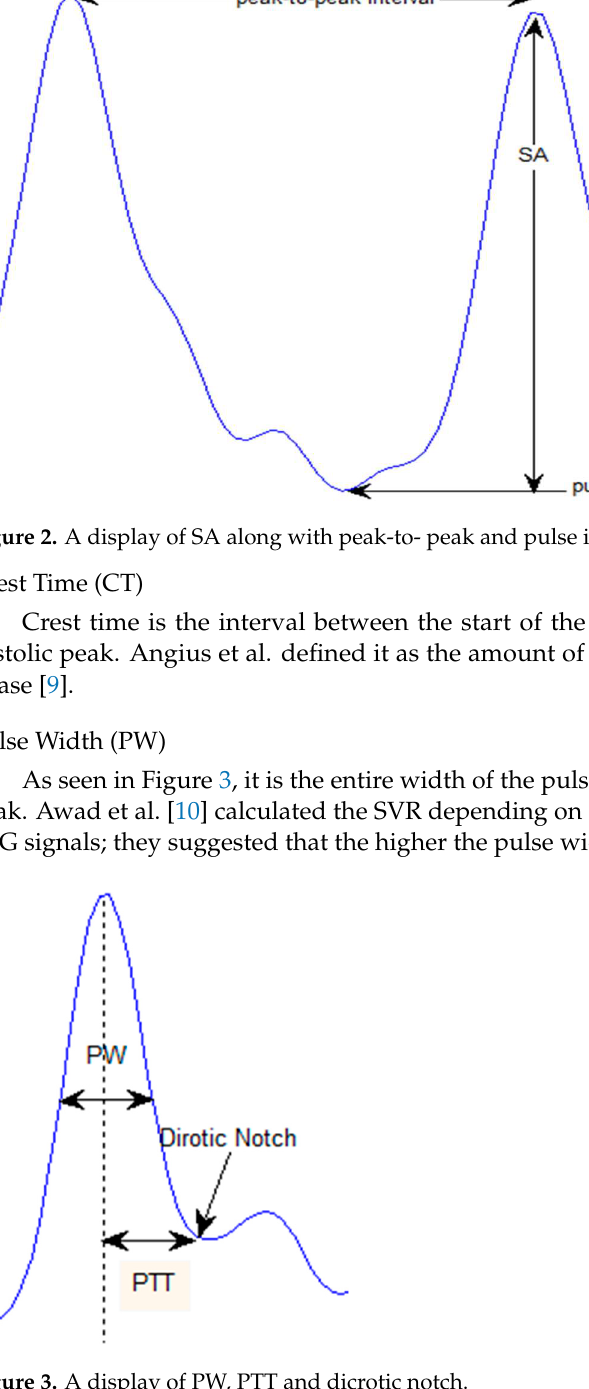
Figure 3. A display of PW, PTT and dicrotic notch.